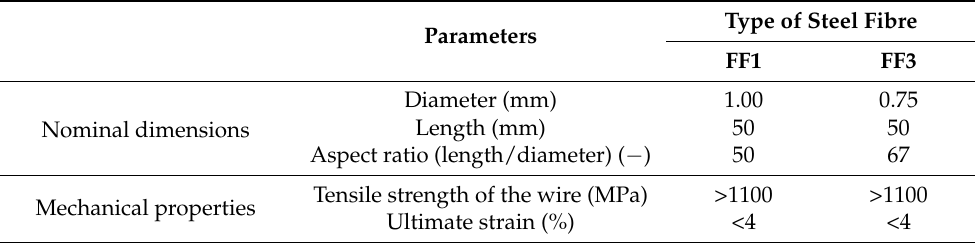
Table 1. Dimensions and mechanical properties of Fibres.